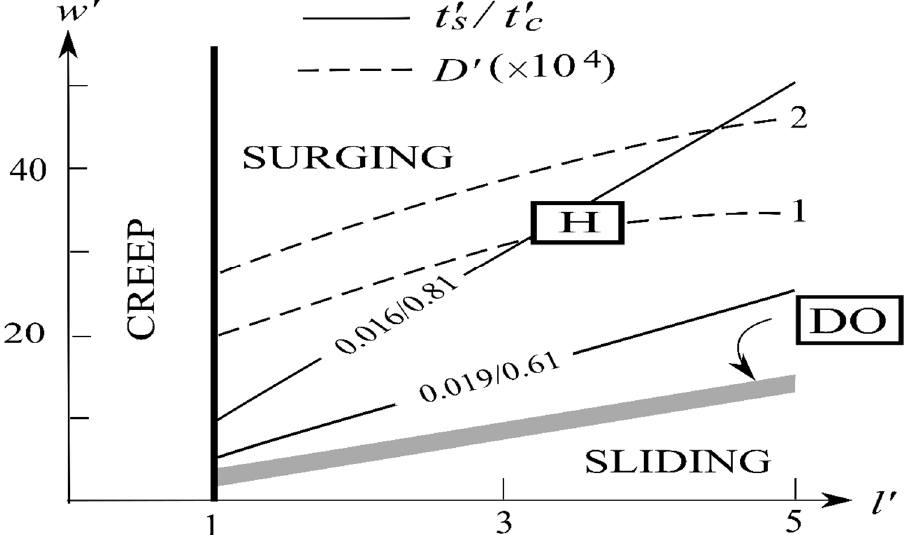
Figure 1. A regime diagram whereby discharge rate (thin dashed line) and surge/creep duration (thin solid line) of the surging ice are plotted against its length/width, all nondimensionalized by scales listed in Table 1. It consists of three dynamic regimes of steady-creep, steady-sliding and cyclic-surge separated by thick and shaded lines. Boxes H and DO mark the H and DO cycles.